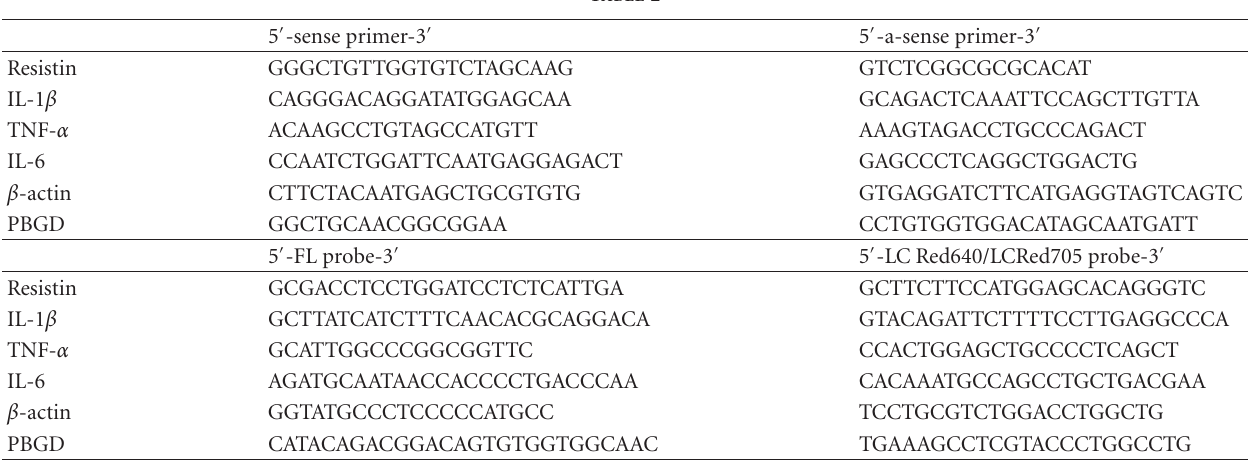
5 (cid:5) -sense primer-3 (cid:5) 5 (cid:5) -a-sense primer-3